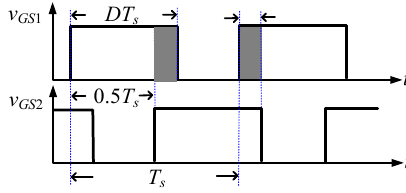
Figure 2. Gate-source voltages v GS1 and v GS2 .